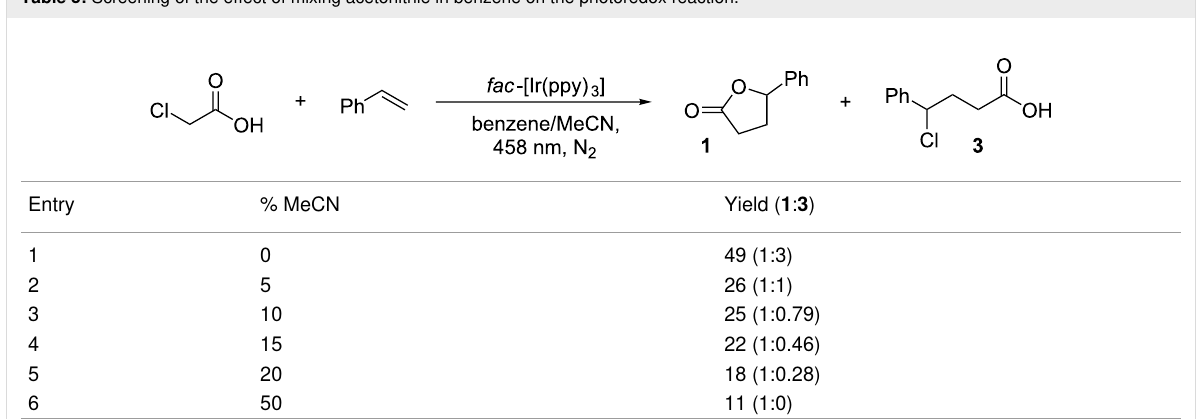
Table 3: Screening of the effect of mixing acetonitrile in benzene on the photoredox reaction. a